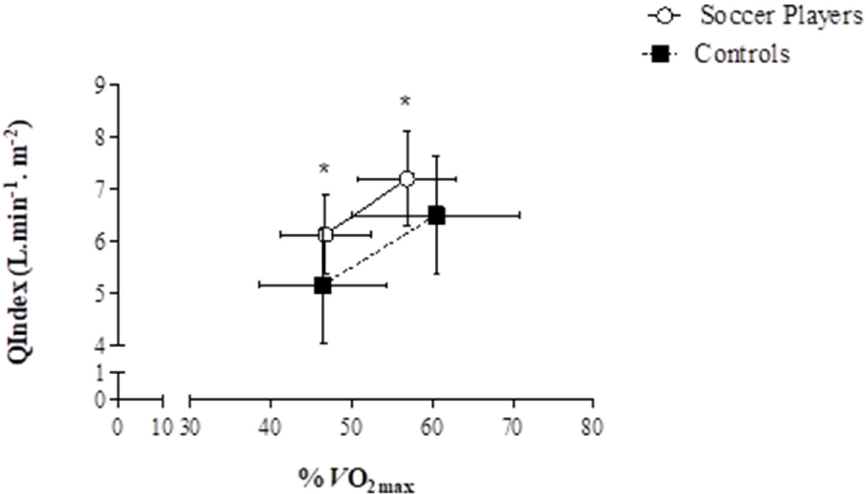
Figure 2. QIndex responses of soccer players ( n = 22) and controls ( n = 15) at the two comparable, relative exercise intensities (RE (1) and RE (2)). The symbols denote the mean values. Horizontal error bars denote the variability (SD) in relative exercise intensity (%VO 2 max) and vertical error bars denote the variability (SD) in QIndex. At both RE (1) and RE (2), the SP demonstrated significantly greater QIndex responses than the CON.* denotes p ≤ 0.05. Unnithan et al., 2018 [33]. Reprinted with permission from Unnithan et al., [33], 2018, John Wiley and Sons.